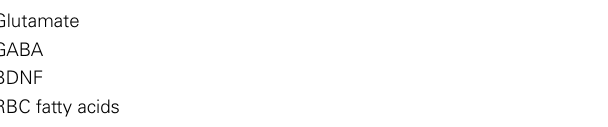
Table 6 | Other potential biomarkers inASD